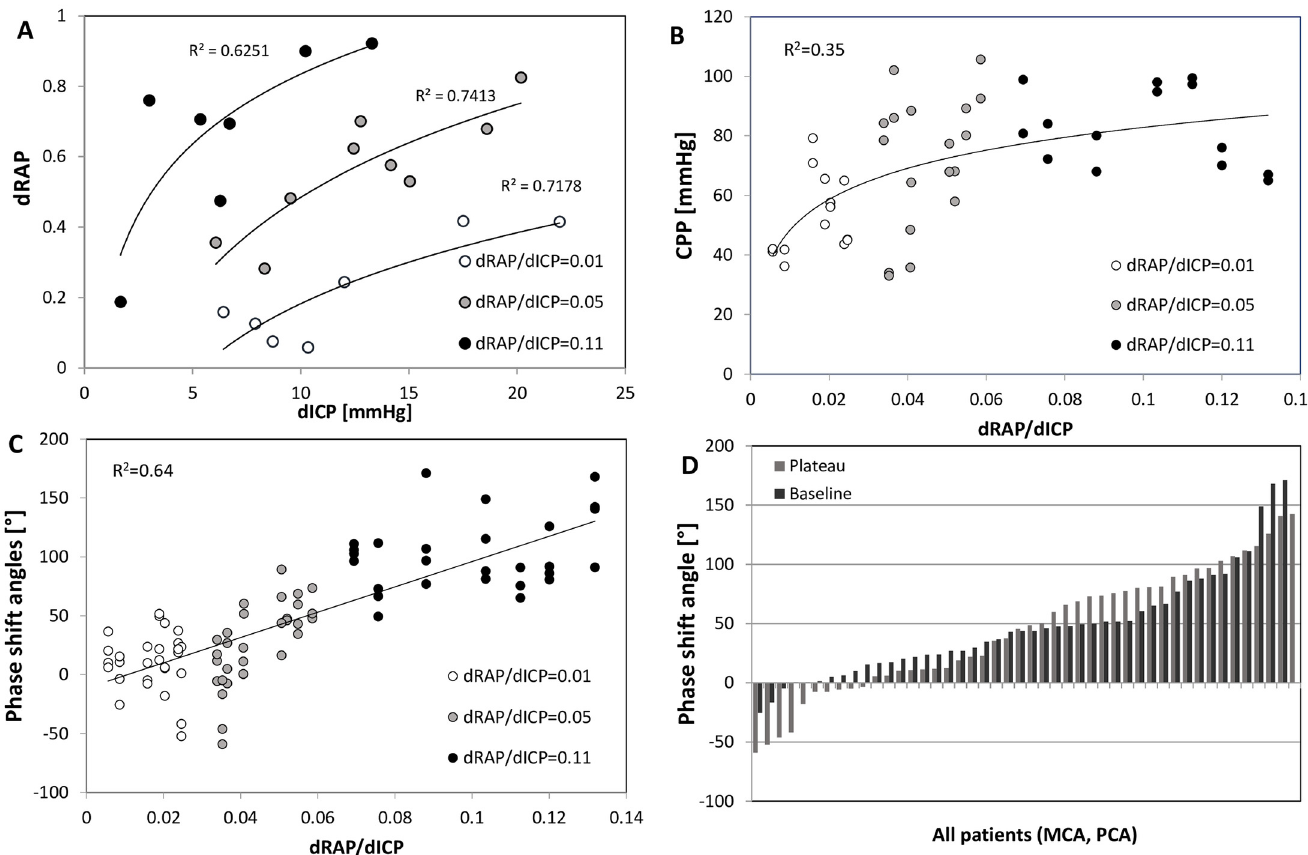
Fig 3. A to D — Relationship between intracranial pressure (ICP), compensatory reserve index (RAP), cerebral perfusion pressure (CPP), and M wave phase shifts. Plotted against each other are dRAP vs dICP, the trend lines mark different slopes, e.g. dRAP/dICP gradients of patients with low (0.01/mmHg), medium (0.05/mmHg), and high (0.11/mmHg) pressure-compliance gradients (A), dRAP/dICP vs. CPP (B), dRAP/dICP vs. M wave phase shift angles (C), and the range of values for phase shift angles across all patients